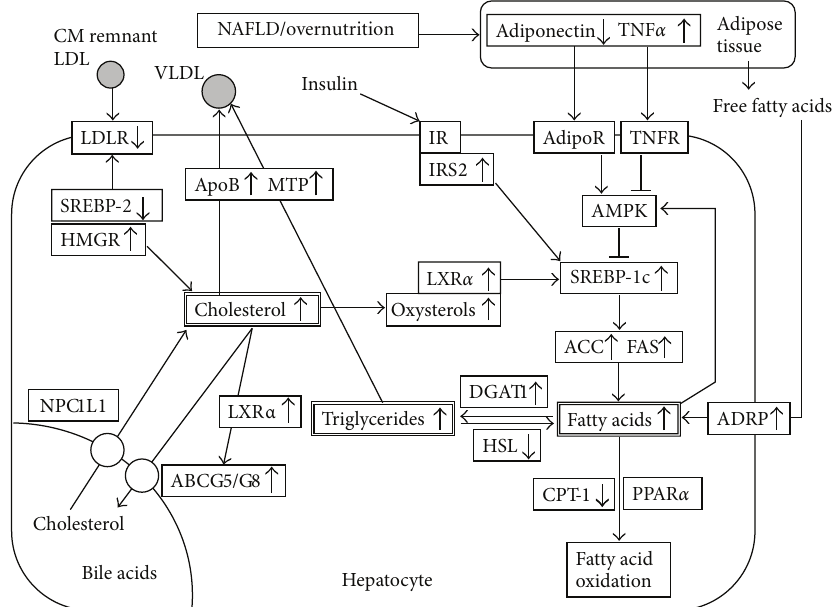
Figure 1: Expression profile of lipid metabolism-associated factors in nonalcoholic fatty liver disease (NAFLD). The established pathophys- iological pathways in NAFLD involve increased delivery of fatty acids to the liver and increased SREBP-1c signaling because of cholesterol overload and insulin resistance. ABCG5/G8: ATP-binding cassette G5/G8; ACC: acetyl-CoA carboxylase; AdipoR: adiponectin receptor; ADRP: adipose di ff erentiation-related protein; AMPK: AMP-activated protein kinase; ApoB: apolipoprotein B; CM: chylomicron;